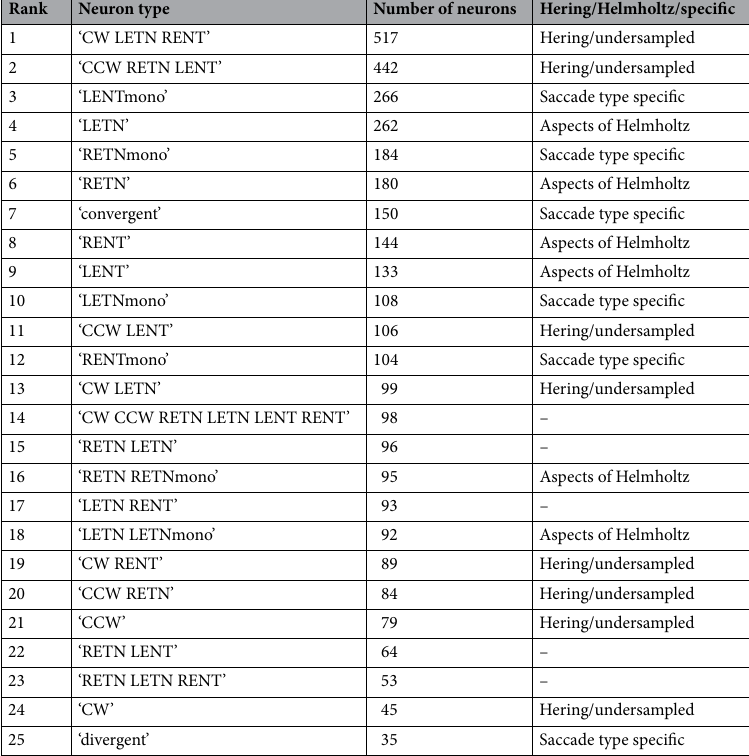
Table 1. The 25 most prominent saccade neuron populations found via saccade-triggered average